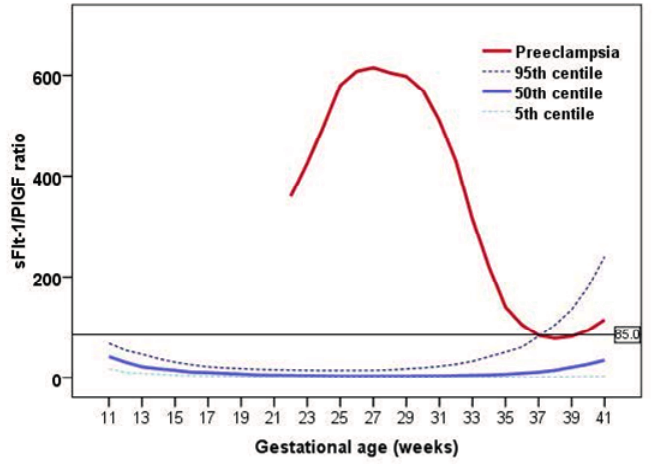
Figure 1. Maternal serum concentrations of the sFlt-1/PlGF ratio throughout pregnancy: reference normal values (5th/50th/95th centiles) are represented in blue and mean values at time of diagnosis of preeclampsia are represented in dark red. Maximum differences between cases and normal pregnancies occur during the early phase, especially at 24–28 weeks. In the late phase, and especially in term pregnancies, considerably overlapping is observed. For visualization, the sFlt-1/PlGF ratio cutoff of 85 is shown as a black horizontal line. Data have been extracted from references 24 and